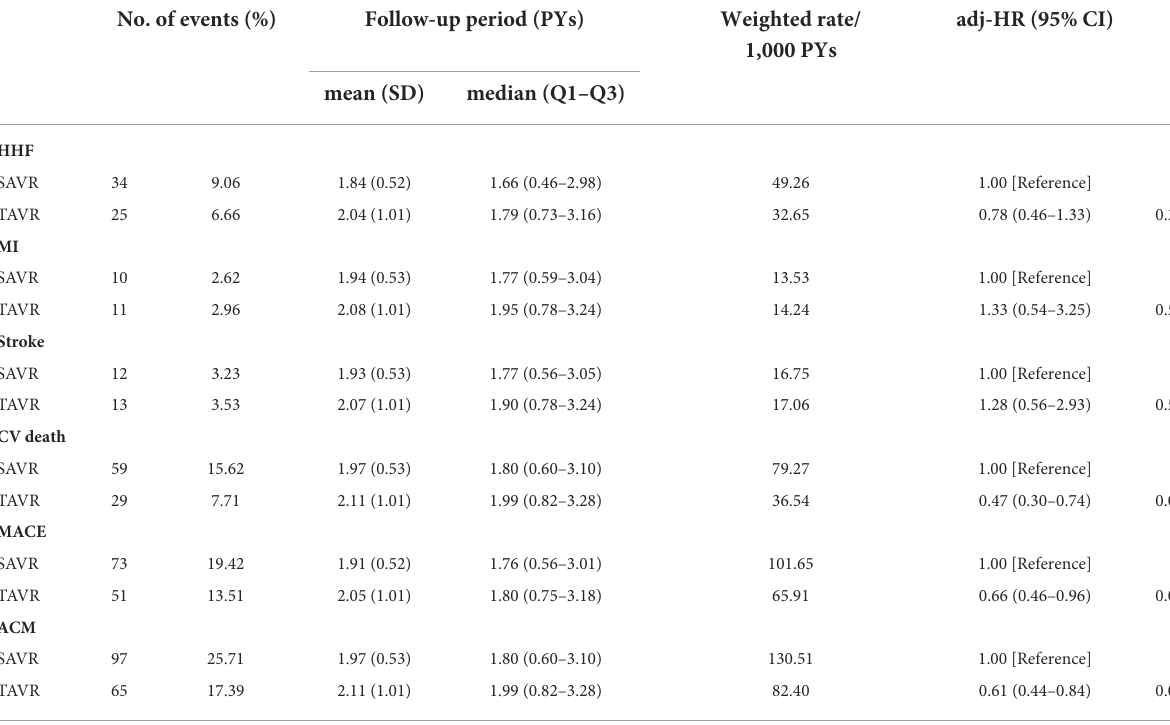
TABLE 2 Comparison of TAVR and SAVR in terms of health outcomes in 3,643 AS patients after propensity score overlap weighting. No. of events